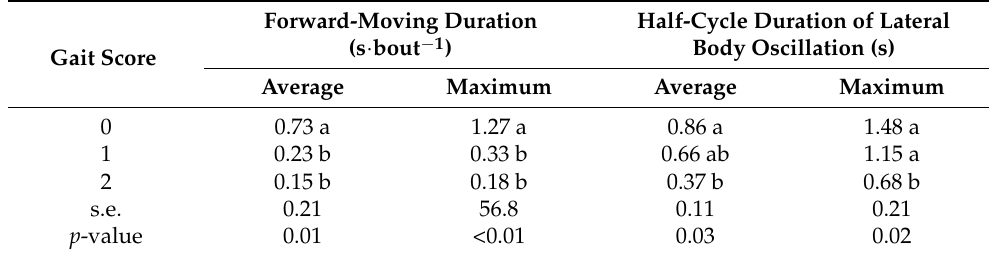
Table 2. Forward-moving duration and half-cycle duration for lateral body